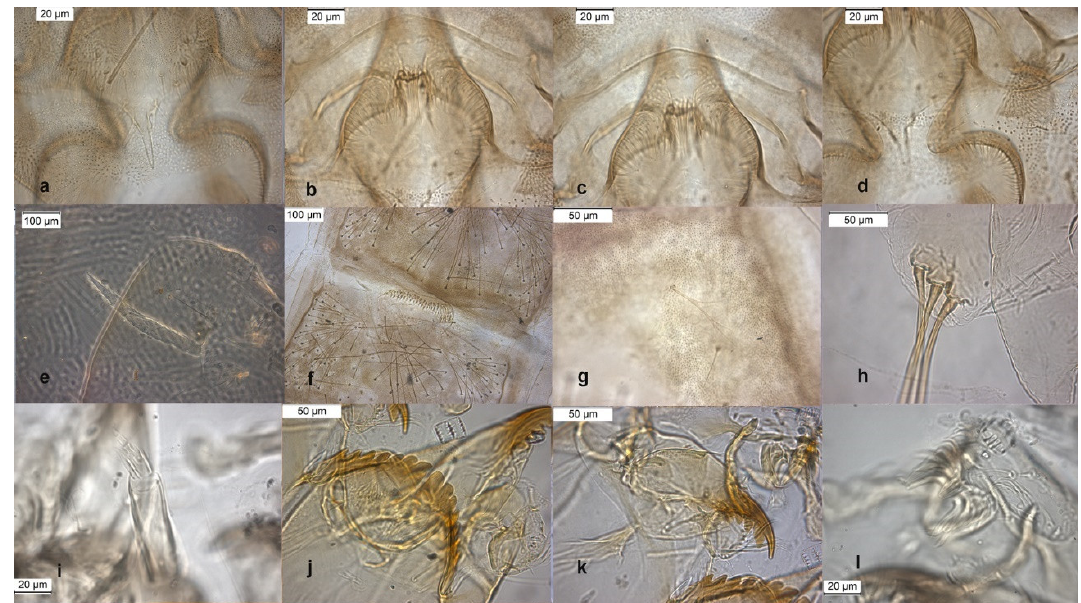
Figure 7. Morphological characters of O. rivinus adult male: ( a ) anal point; ( b ) virga; ( c ) superior volsella; ( d ) inferior volsella; pupal exuvia: ( e ) thoracic horn, ( f ) tergite II; ( g ) sternite III; ( h ) taeniate extensions; larva: ( i ) antenna; ( j ) mentum; ( k ) mandible; ( l )